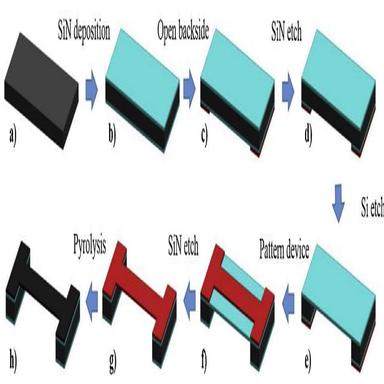
Fabrication process of pyrolytic carbon string resonators with backside opening window, a) Silicon wafer, b) SiN deposition, c) Photolithography to open window on backside, d) SiN etched from backside, e) Si etch through wafer, f) String patterning by SU-8 lithography, g) Etching of SiN membranes, h) Pyrolysis to obtain carbon string.